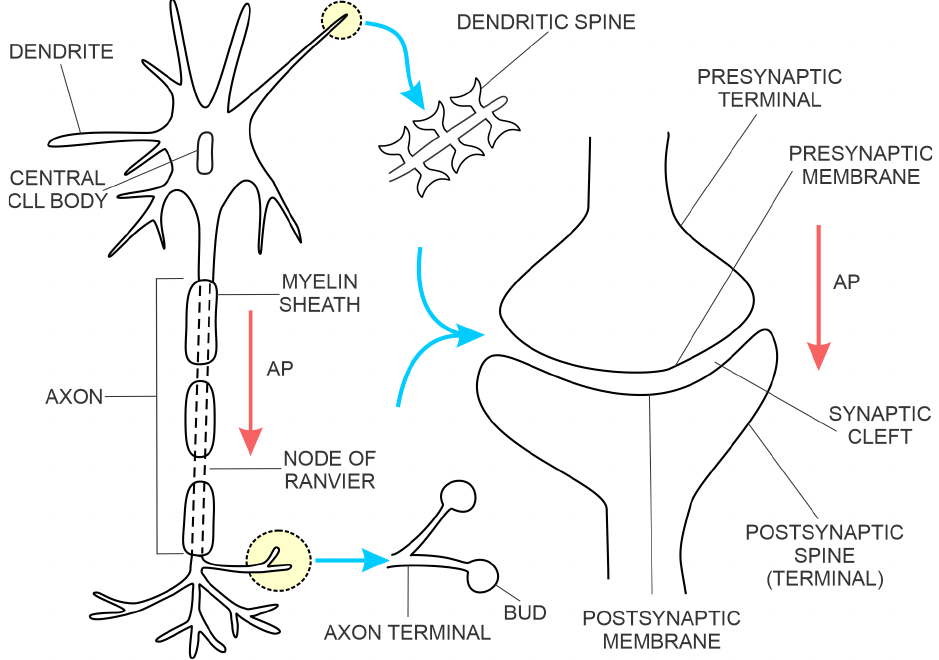
Figure 1. Nerve cell. Abbreviation: (AP with red arrows) direction of action potential transmission.